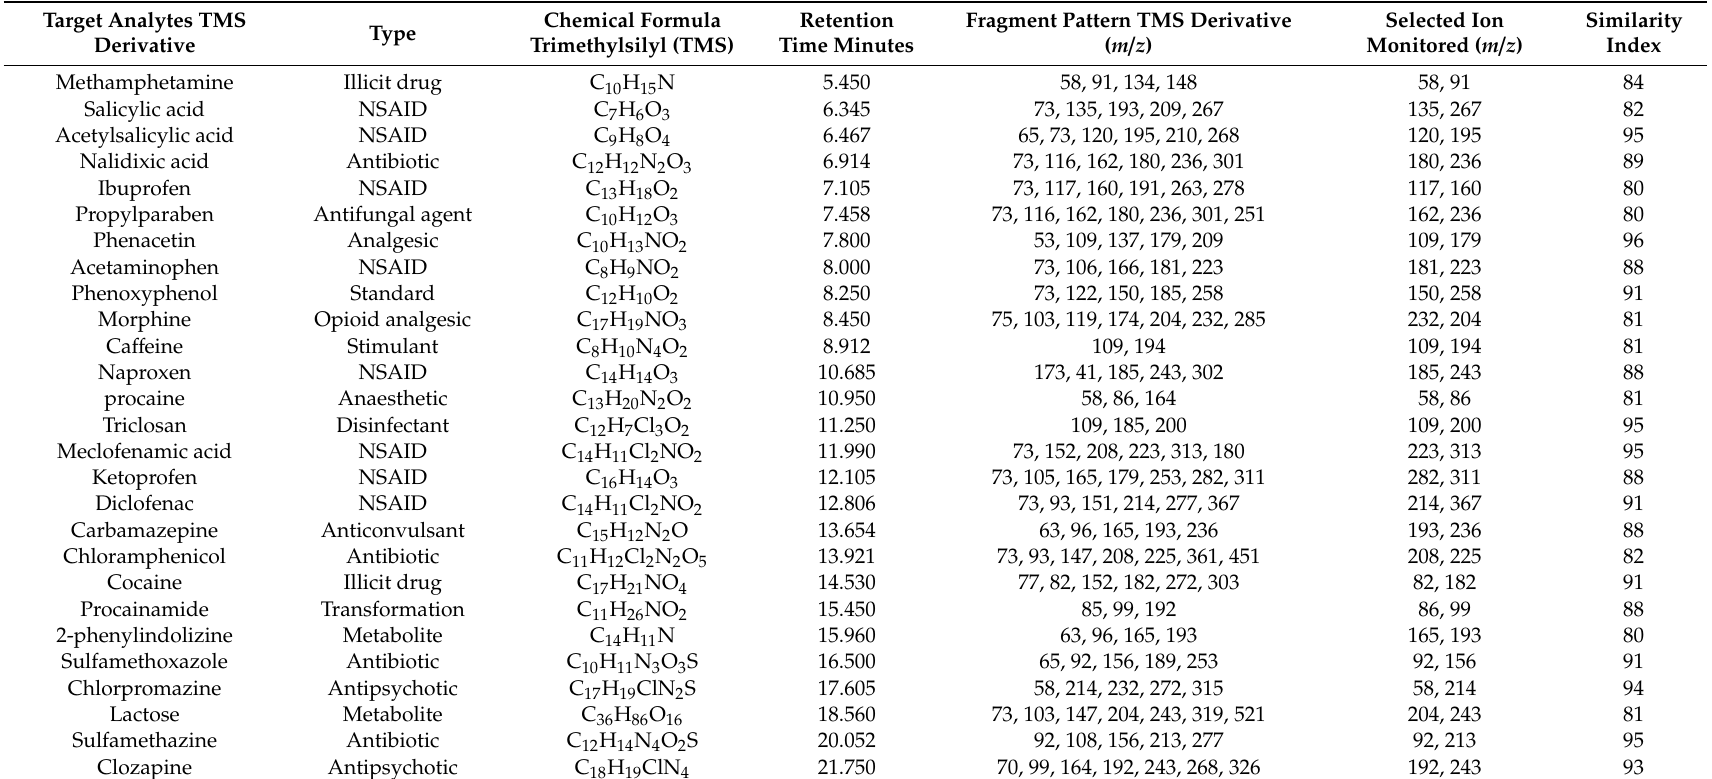
Table 1. Derivatized pharmaceutical and personal care GC-MS products obtained by injecting target